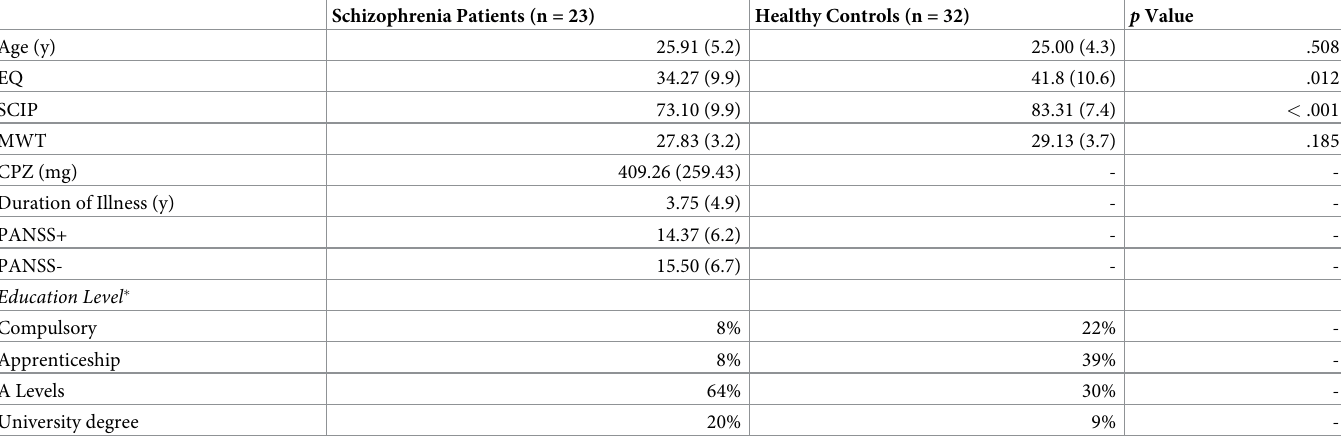
Table 1. Demographic data and clinical ratings of patients with SSD and